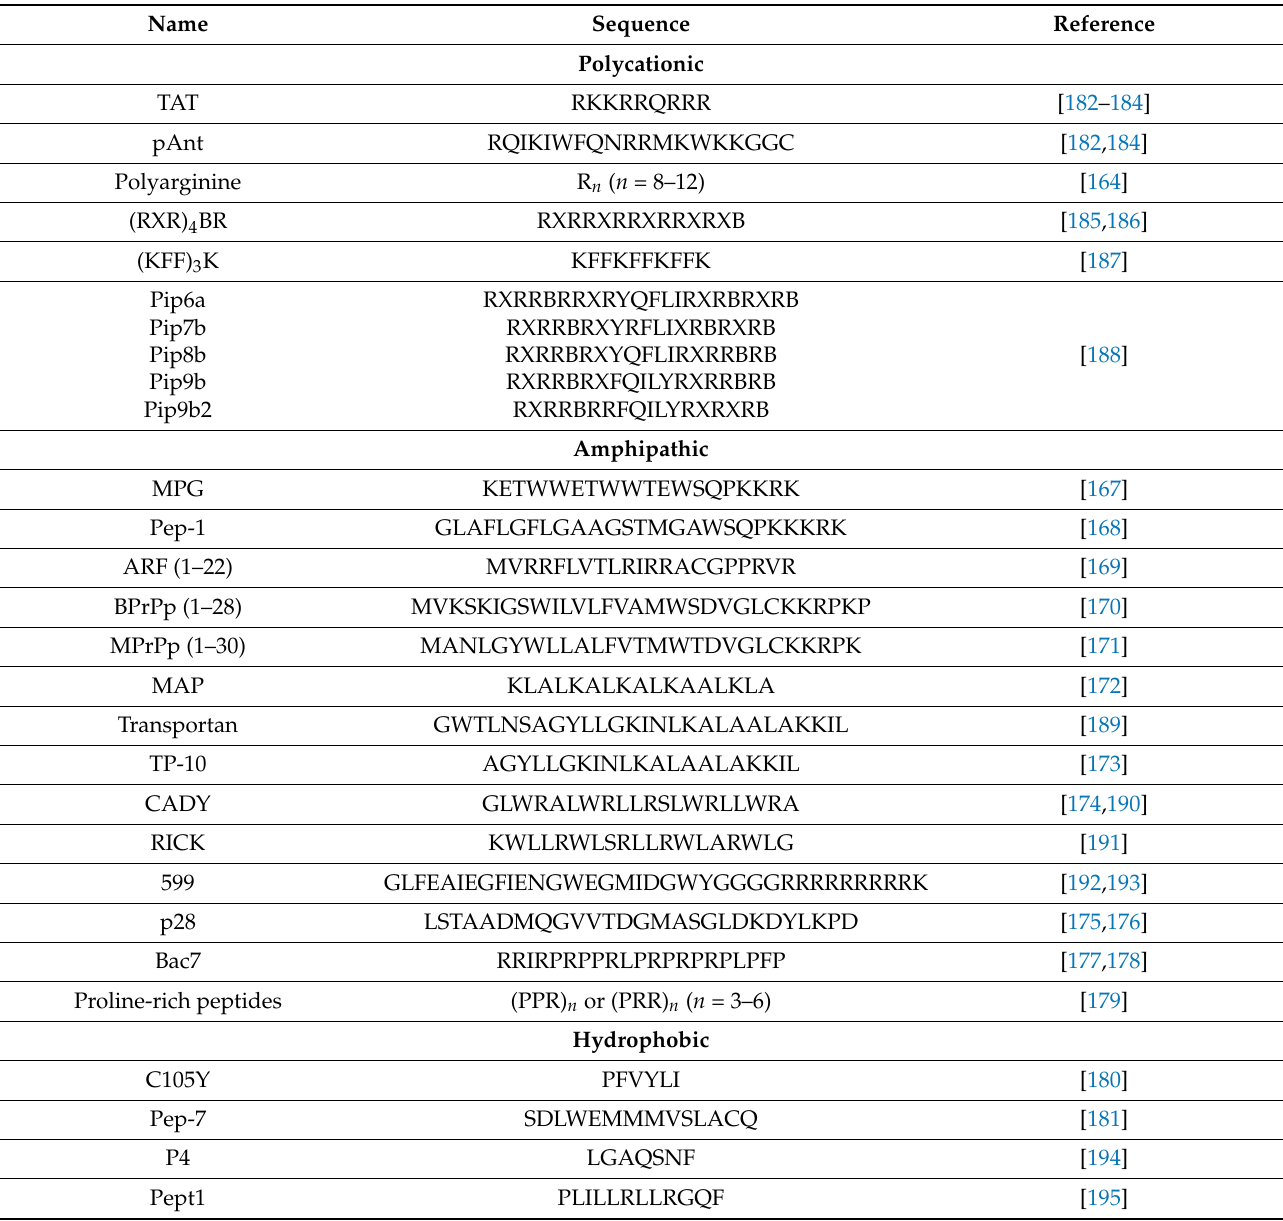
Table 1. Most common CPPs used for the delivery of therapeutic nucleic